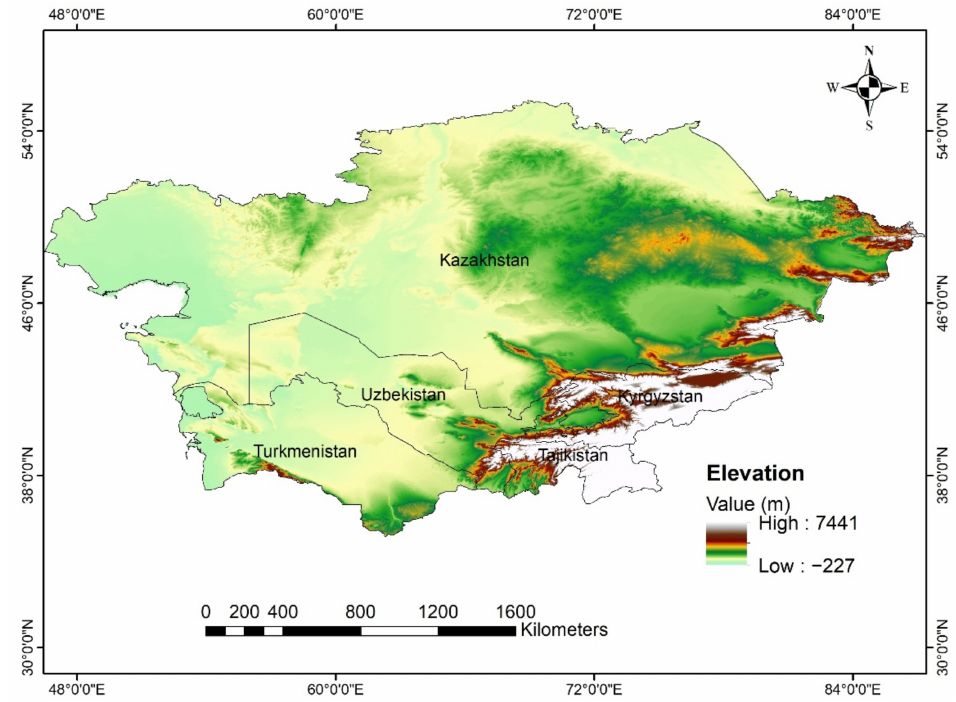
Figure 1. Digital elevation map of Central Asia (Source: USGS SRTM 90 m).